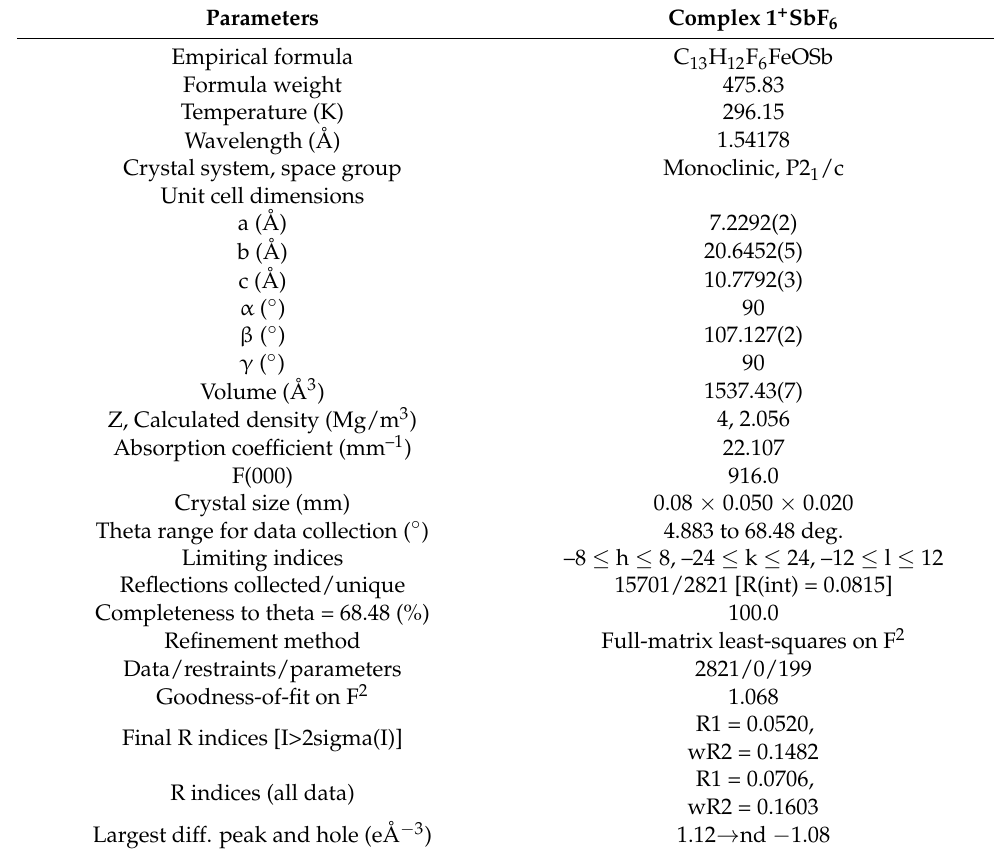
Table 1. Crystal Structure Refinement of 1 + SbF 6